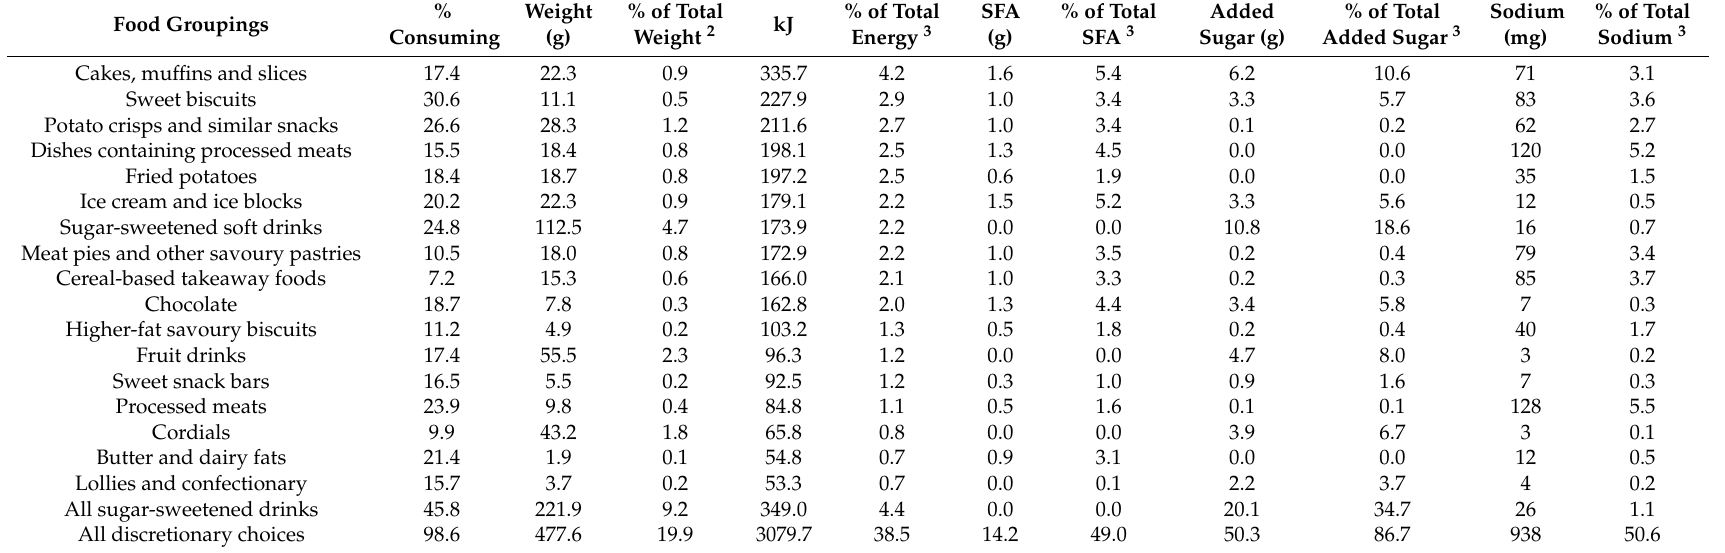
Table 1. Mean per capita intake of discretionary choice subgroups by children and adolescents aged 2–18 y in NNPAS 2011–12 ( n = 4,770,094 1